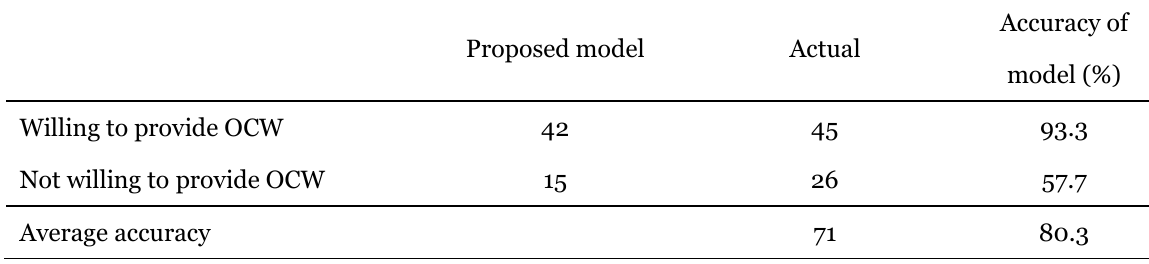
Accuracy of a Model to Predict Willingness to Provide OCW in Future